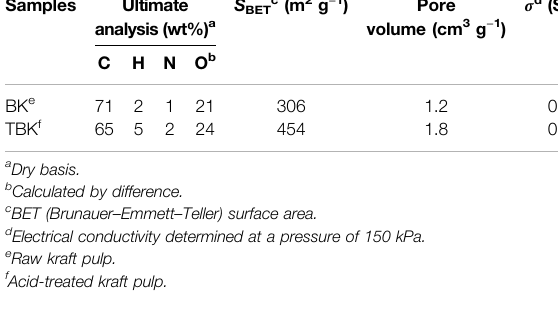
Frontiers in Materials |